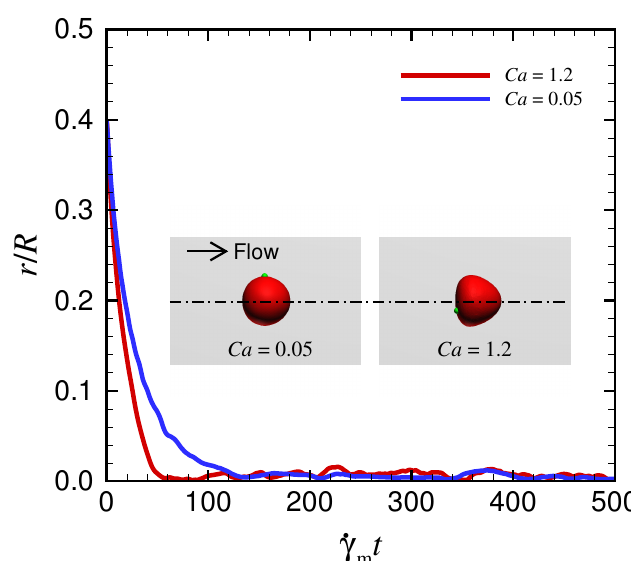
Figure A3. Time history of radial position of capsule centroid for different Ca (0.05 and 1.2), where the insets are the snapshots of flowing spherical capsule at steady state for each Ca (see also Videos S5 and S6). The results were obtained with Re = 0.2 and λ =